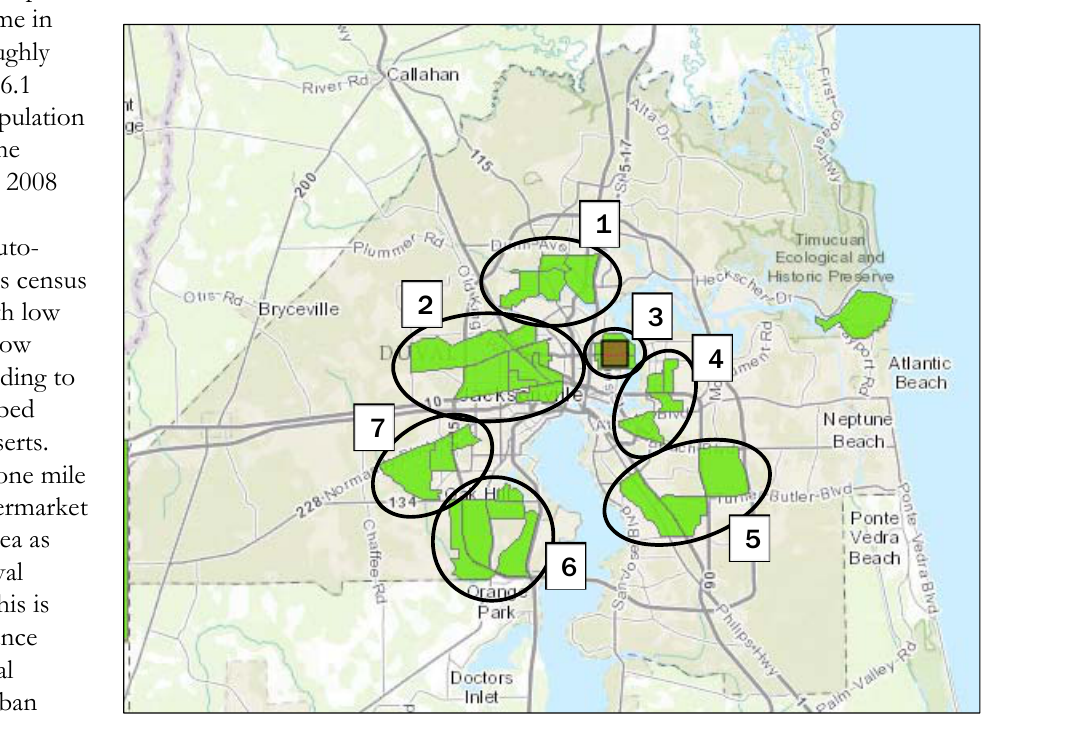
Figure 4. Seven Food Desert Clusters in Duval County, Florida, Showing Census Tracts with Contiguous Borders That Are Both Low Access